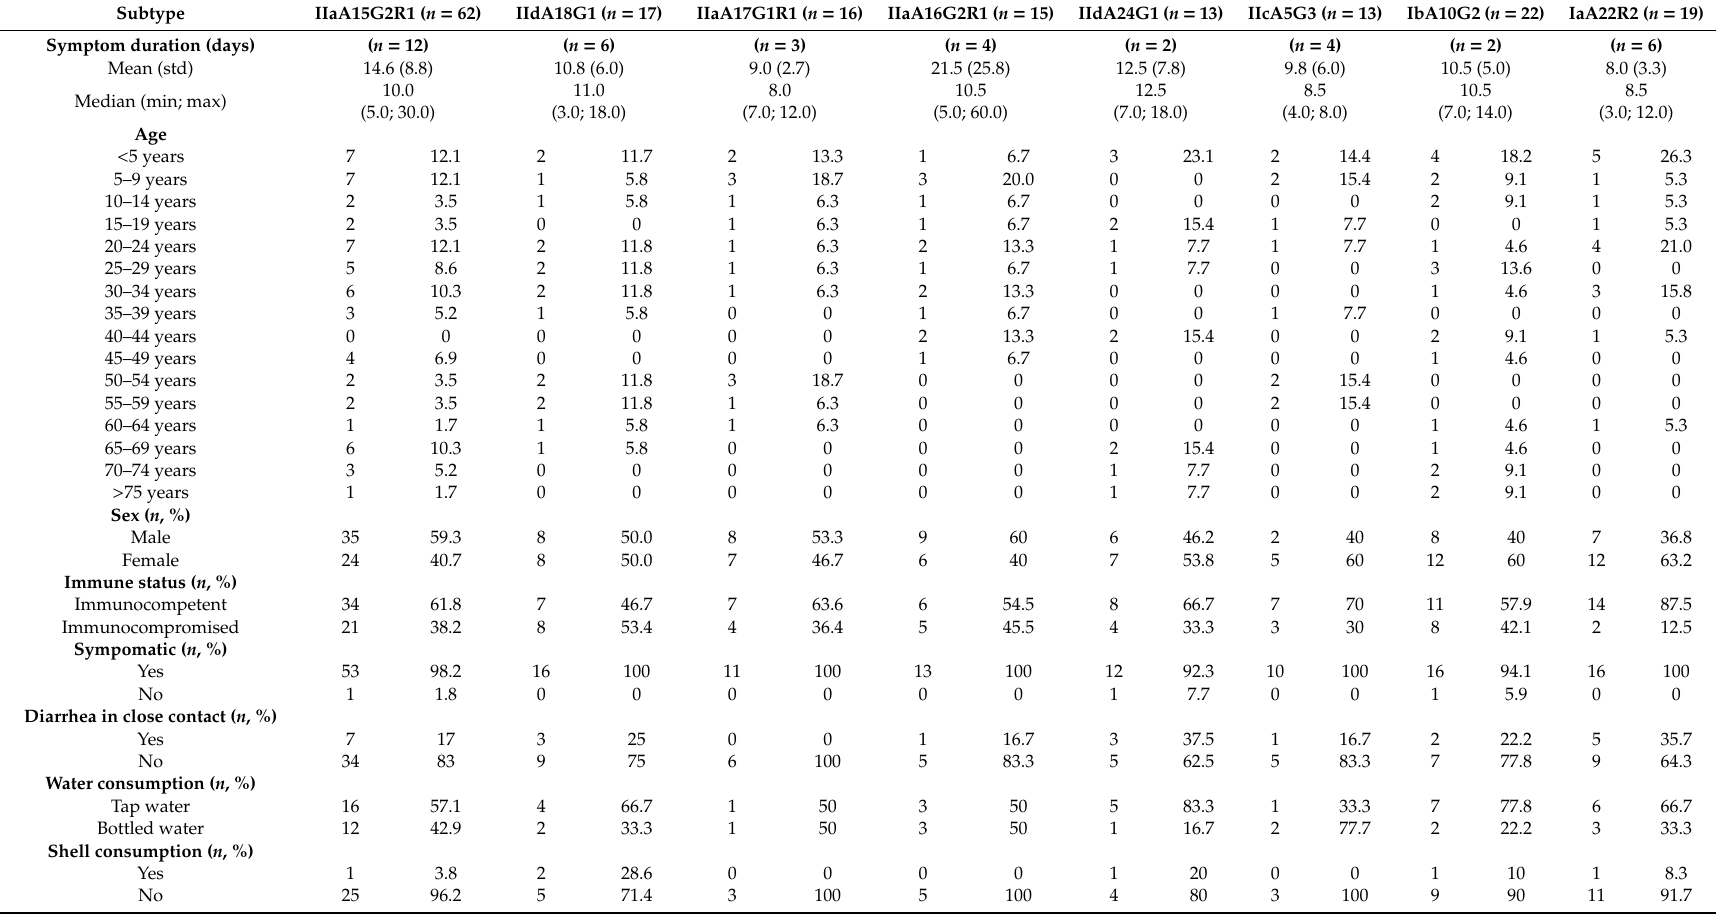
Table A1. Notified parameters of epidemiology and potential risk factors in the main